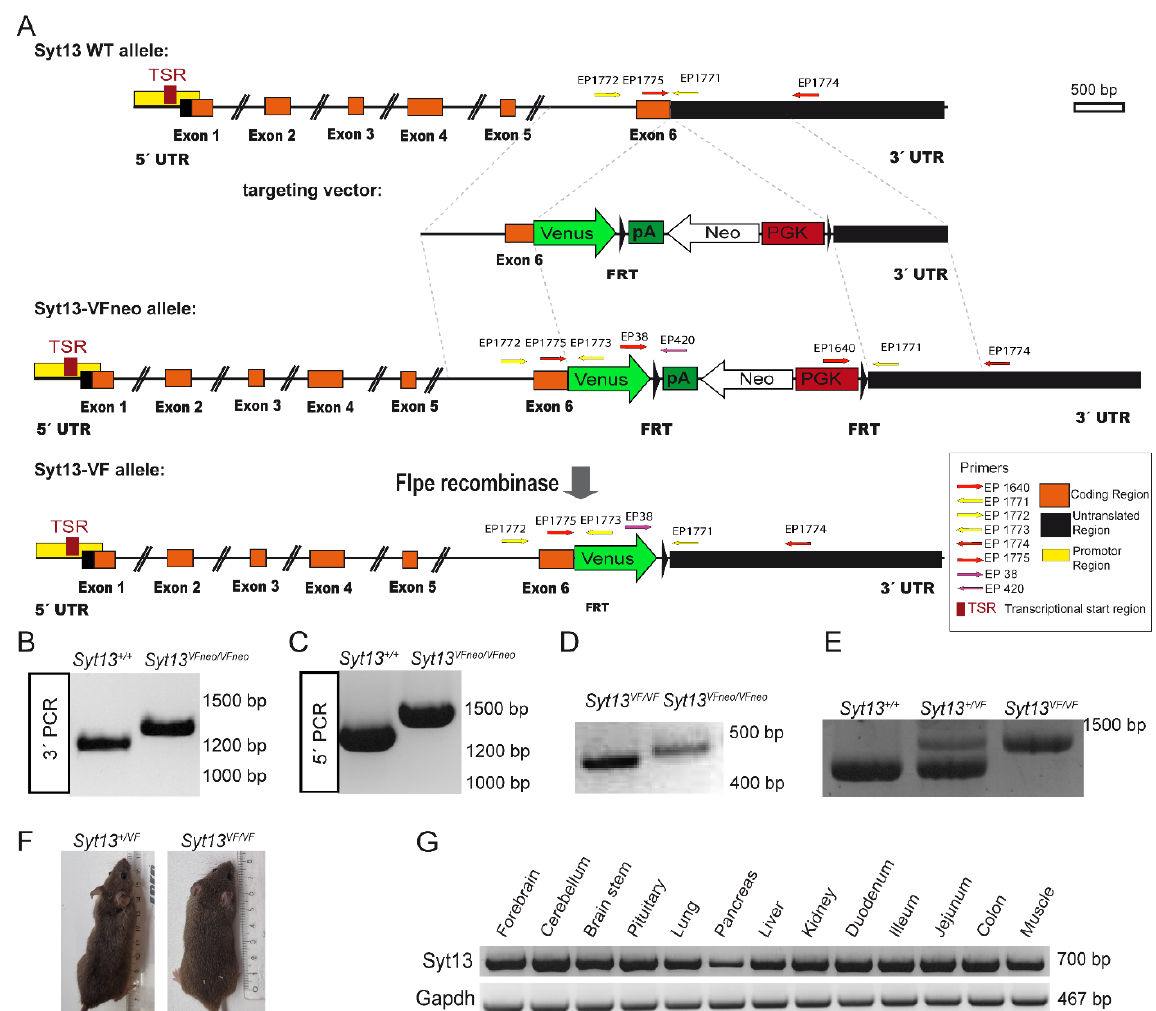
Figure 1. Generation of the Syt13 Venus Fusion (Syt13-VF) allele. ( A ) Targeting strategy of the Syt13-VF allele. A double strand break was performed by two nickases of the D10A mutant Cas9 using two gRNAs binding before and after the stop codon of Syt13. A targeting vector was used to repair the gap and fuse the coding region of the fluorescent reporter gene Venus to the open reading frame. The FRT-flanked PGK-driven neomycin (Neo) selection cassette was removed by Flpe recombinase-mediated excision. Syt13 5 ′ and 3 ′ untranslated regions (UTRs) are indicated in black and the predicted promoter region in yellow and the transcriptional start sites (TSR) in red as indicated. Primers used for genotyping EP_1771, EP_1772 and EP_1773 are indicated with yellow arrows. The position of the homology regions to generate the targeting construct are indicated (dashed lines). ( B , C ) PCR genotyping of Syt13VFNeo clones using primers EP_1640, EP_1774 and EP1775 (red arrows) confirming the targeted allele Syt13-VFNeo (1335 bp) versus the WT allele (1228 bp) and for 3 ′ PCR and EP_1771, EP_1772, and EP_1773 for 5 ′ PCR (yellow arrows) confirmation of Syt13-VFNeo (1475 bp) versus WT allele (1322 bp). ( D ) PCR primers EP038, EP420, and EP 1771 were used to distinguish the allele before (Syt13-VFNeo; 477 bp) and after removal of the Neo selection cassette (Syt13-VF; 402 bp). ( E ) Primers EP_1771, EP_1772, and EP_1773 were used to distinguish WT from heterozygous or homozygous mice resulting in 1322 bp for the WT allele and 1475 bp for the Syt13-VF allele. ( F ) Side by side image of a WT male mice (left) and a Syt13-VF male mouse (right) of 5 months of age. ( G ) RT-PCR of different tissues of a WT adult mouse presenting bands corresponding to Syt13 and Gapdh